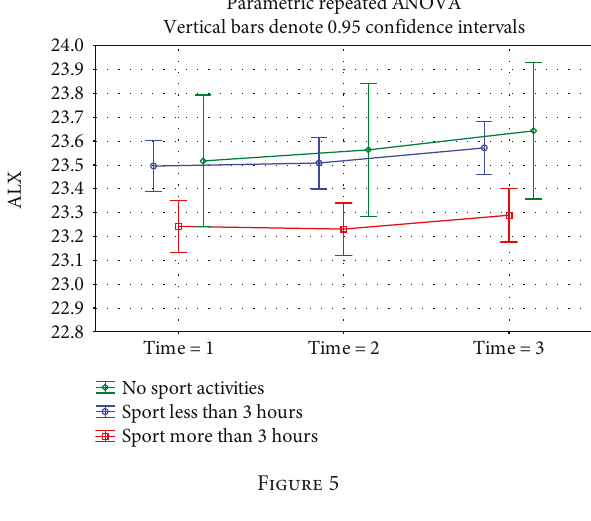
Parametric repeated ANOVA Vertical bars denote 0.95 confidence